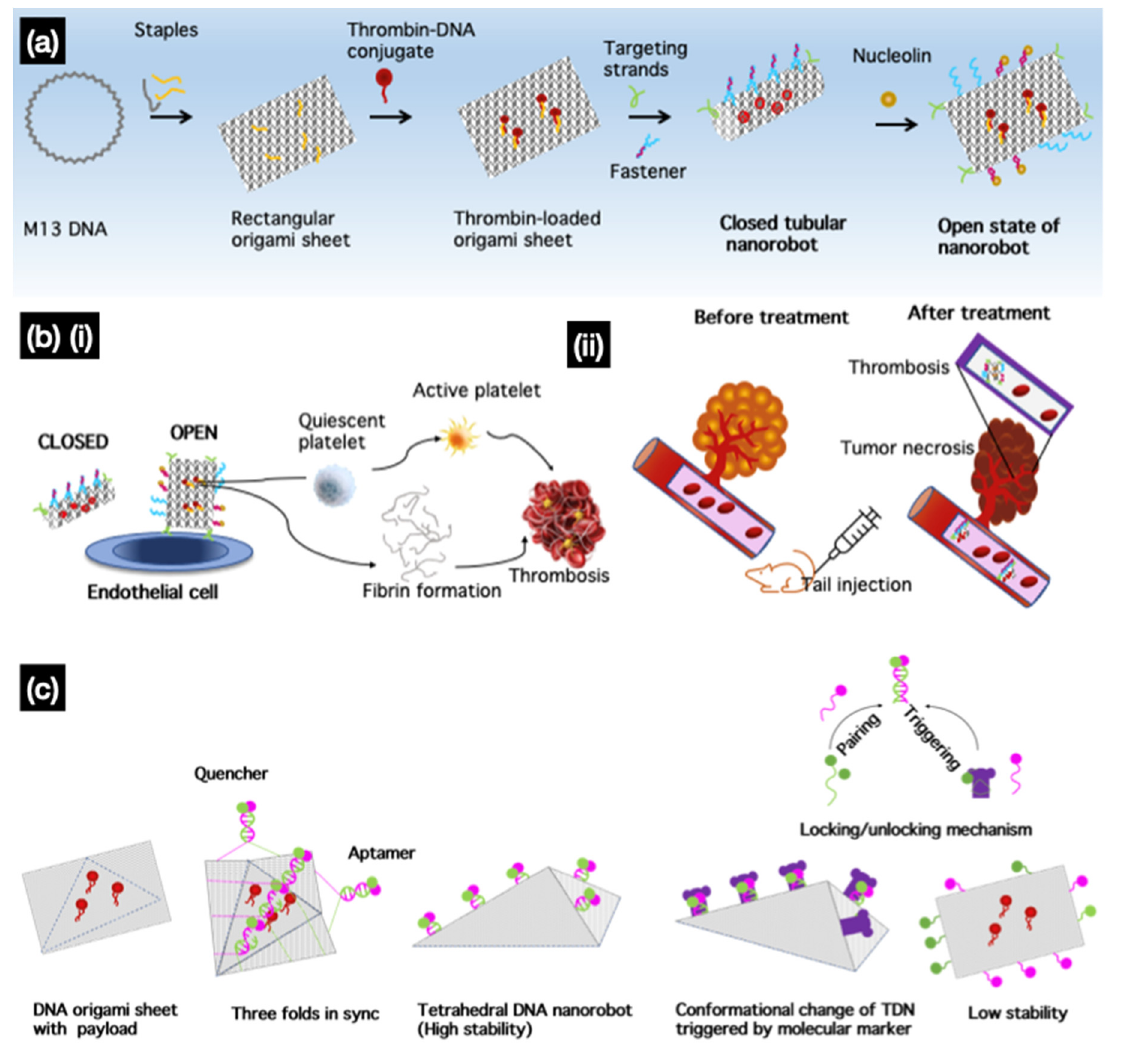
Figure 8 . Application of DNA nanorobots for targeted therapy. ( a ) Construction of a nanorobot-Th through DNA origami. The closed tubular nanorobot opens upon sensing nucleolin to open the DNA origami sheet. ( b ) ( i ) The mechanism of action of nanorobot-Th in plasma in the presence of vascular endothelial cells. ( ii ) The therapeutic mechanism of nanorobot-Th within tumor vessels. DNA nanorobot-Th administered to tumor xenografted mice via tail vein injection binds to the vascular endothelium by recognizing nucleolin and opens to expose its thrombin cargo which induces localized thromboses, tumor infarction, and cell necrosis. Redrawn from [76]. ( c ) Dynamic DNA